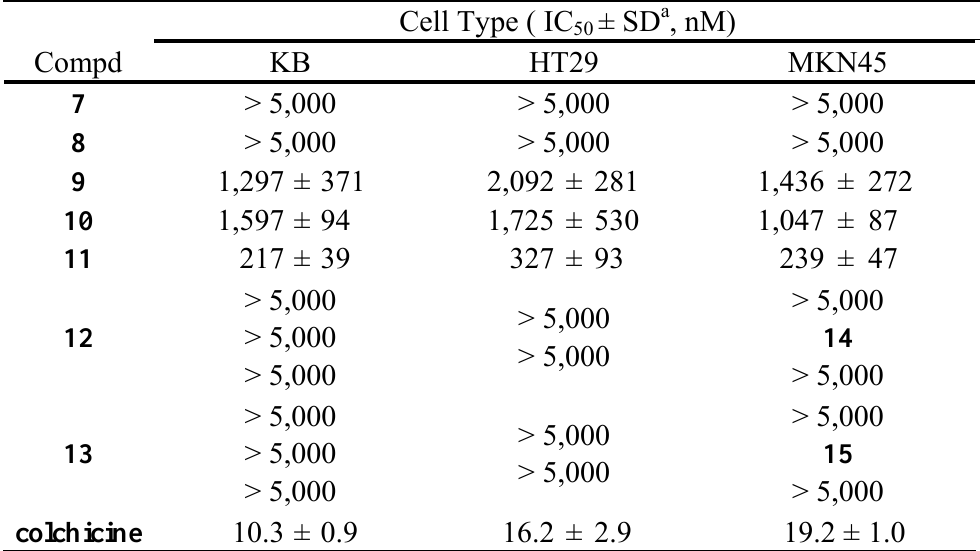
Table 1. IC Values (nM ± SD a ) of Compounds 7 – 13 . 50